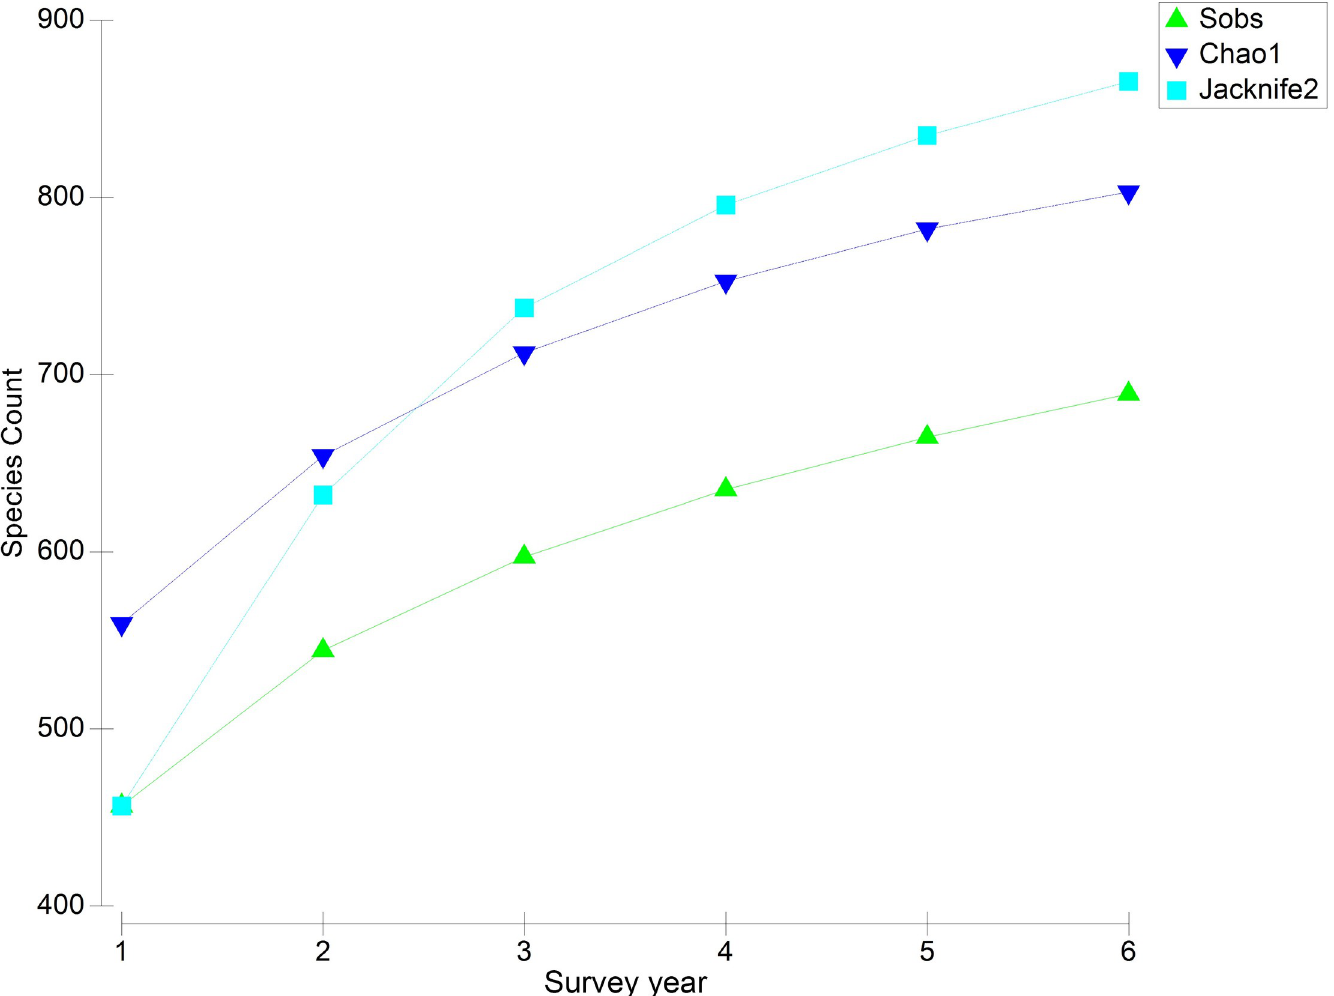
Fig 1. Species accumulation curve for all animal species, showing the rate of new species records accumulating across survey years. Survey year represents the year during the study period (i.e. 1 = 2013–14; 6 = 2018–19).